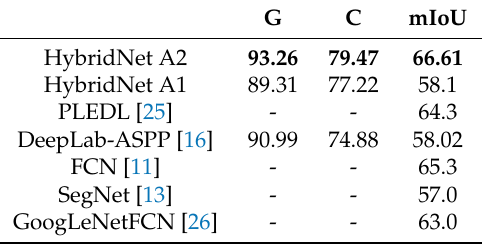
Figure 5. Semantic segmentation qualitative results. A comparison between semantic segmentation estimation against ground truth is presented. From left to right, input image is depicted in the first column. In column 2 the segmentation map estimated by DeepLab-ASPP semantic segmentation network [28] is presented, in column 3 the estimated segmentation map by our hybrid method are presented and finally the ground truth is depicted in column 4. Table 2. Evaluation of HybridNet against Multi-task and single-task approaches (best results in